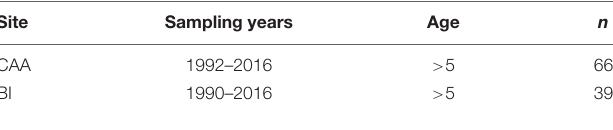
TABLE 1 | Sampling years, age class and number of muscle samples ( n ) of ringed seals from the Canadian Arctic Archipelago (CAA) and the Baffin Island (BI).